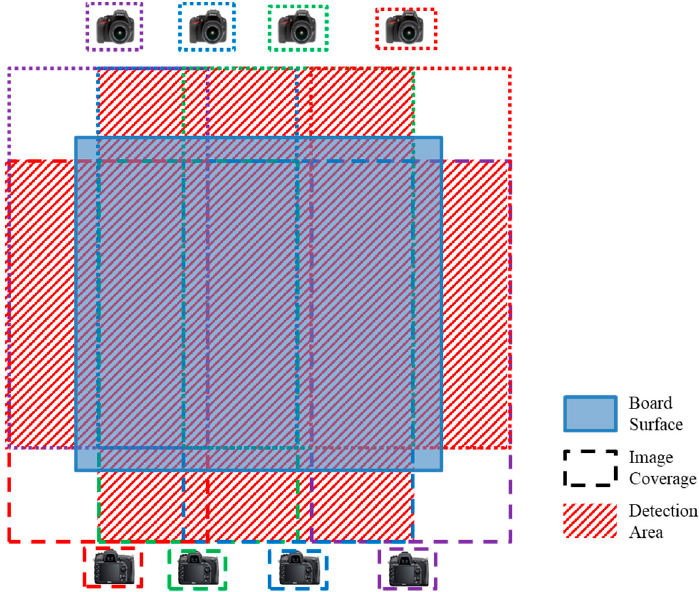
Figure 4. Illustration of the detection area for the CGC-CRP method (Top view, the dashed lines in different colors delineate the photo coverage area of each camera position, and the overlap of these areas is the detection area of the Digital Elevation Model (DEM)).